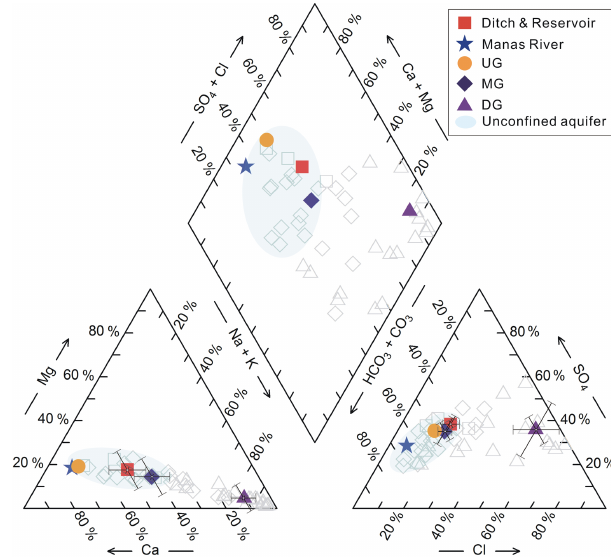
Figure 6. Piper diagram highlights the HCO 3 –SO 4 –Na type of wa- ters. The coloured symbols represent the mean values calculated from the hydrochemistry data (light grey hollow symbols) reported by Ma et al. (2018). The error bars are shown in the cation and anion